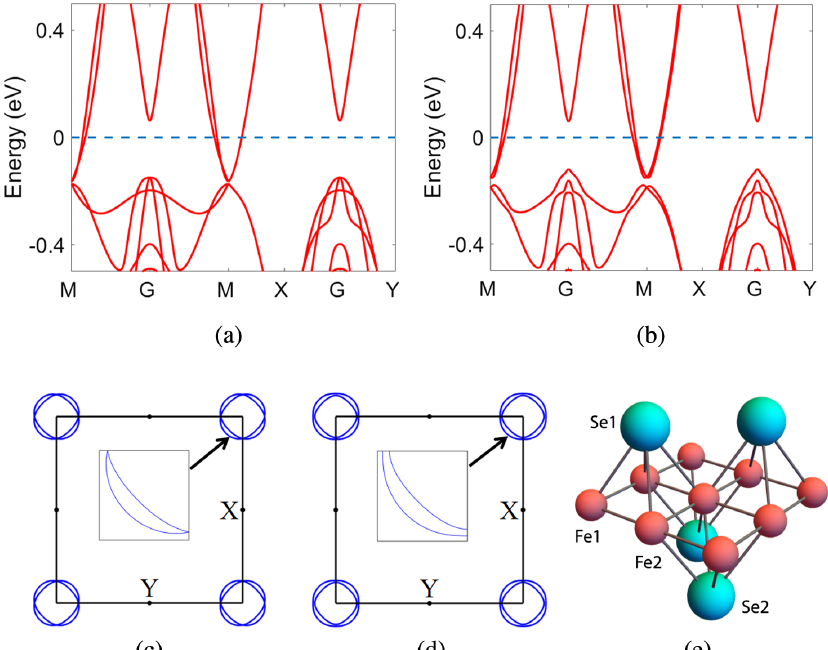
FIG. 9. (a) and (b) show the normal-state band structures of the monolayer FeSe in the absence and presence of spin-orbit coupling, respectively. The corresponding Fermi surfaces are shown in (c) and (d), with the insets showing the details. The chemical potential is set to be μ ¼ 118 . 3 meV, and the spin-orbit coupling λ ¼ 40 meV here. We also show the lattice structure of the monolayer FeSe in (e).